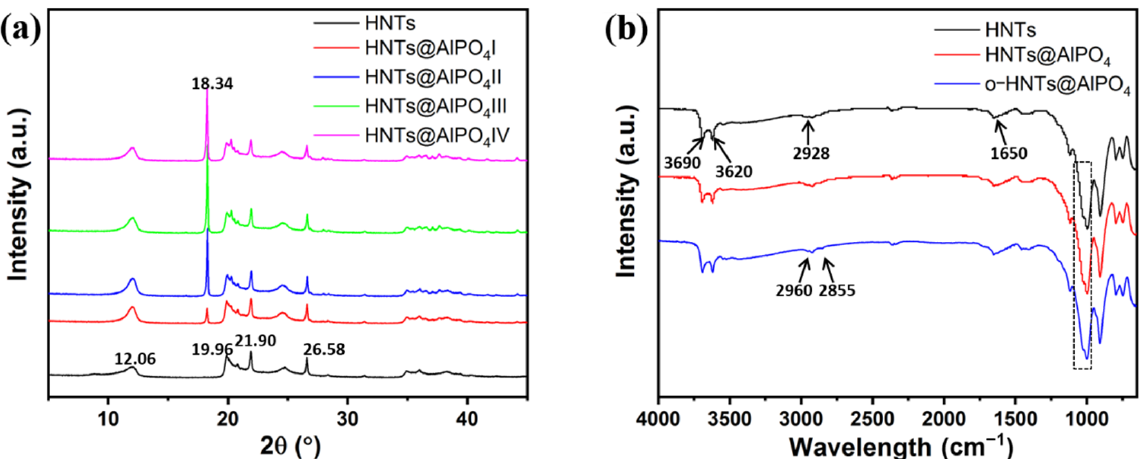
Figure 3. ( a ) The XRD curves of the pure HNTs and HNTs@AlPO 4 composites and ( b ) IR curves